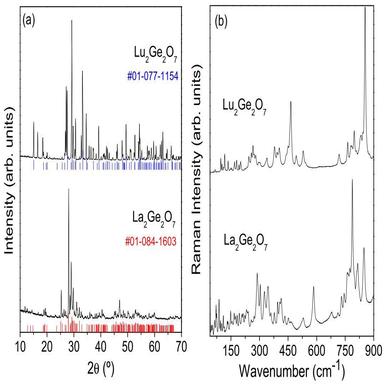
(a) XRD data for typical triclinic (La2Ge2O7) and tetragonal (Lu2Ge2O7) ceramics with their respective reference JCPDS cards: #01-084-1603 (red bars) and #01-077-1154 (blue bars); (b) Raman spectra for the same materials, showing the fingerprints of both crystal structures. The structural data (XRD and Raman spectra) for the complete Ln2Ge2O7 series can be found in a previous publication.